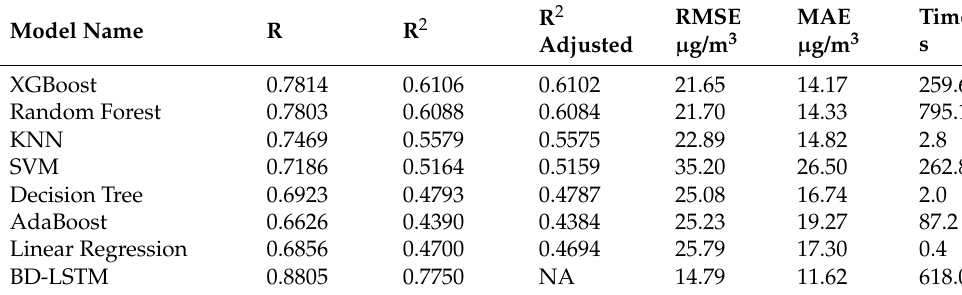
Table 4. Summer cross-validation results (March, April, and May).